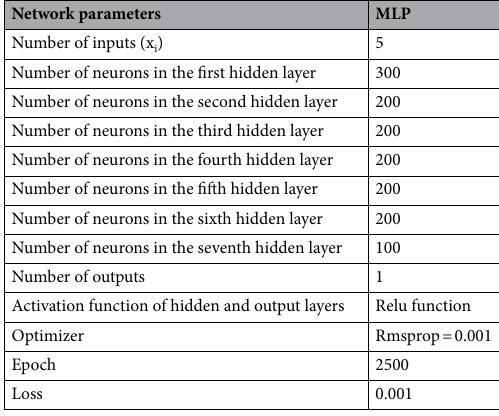
Table 1. The specifications of the suggested MLP.